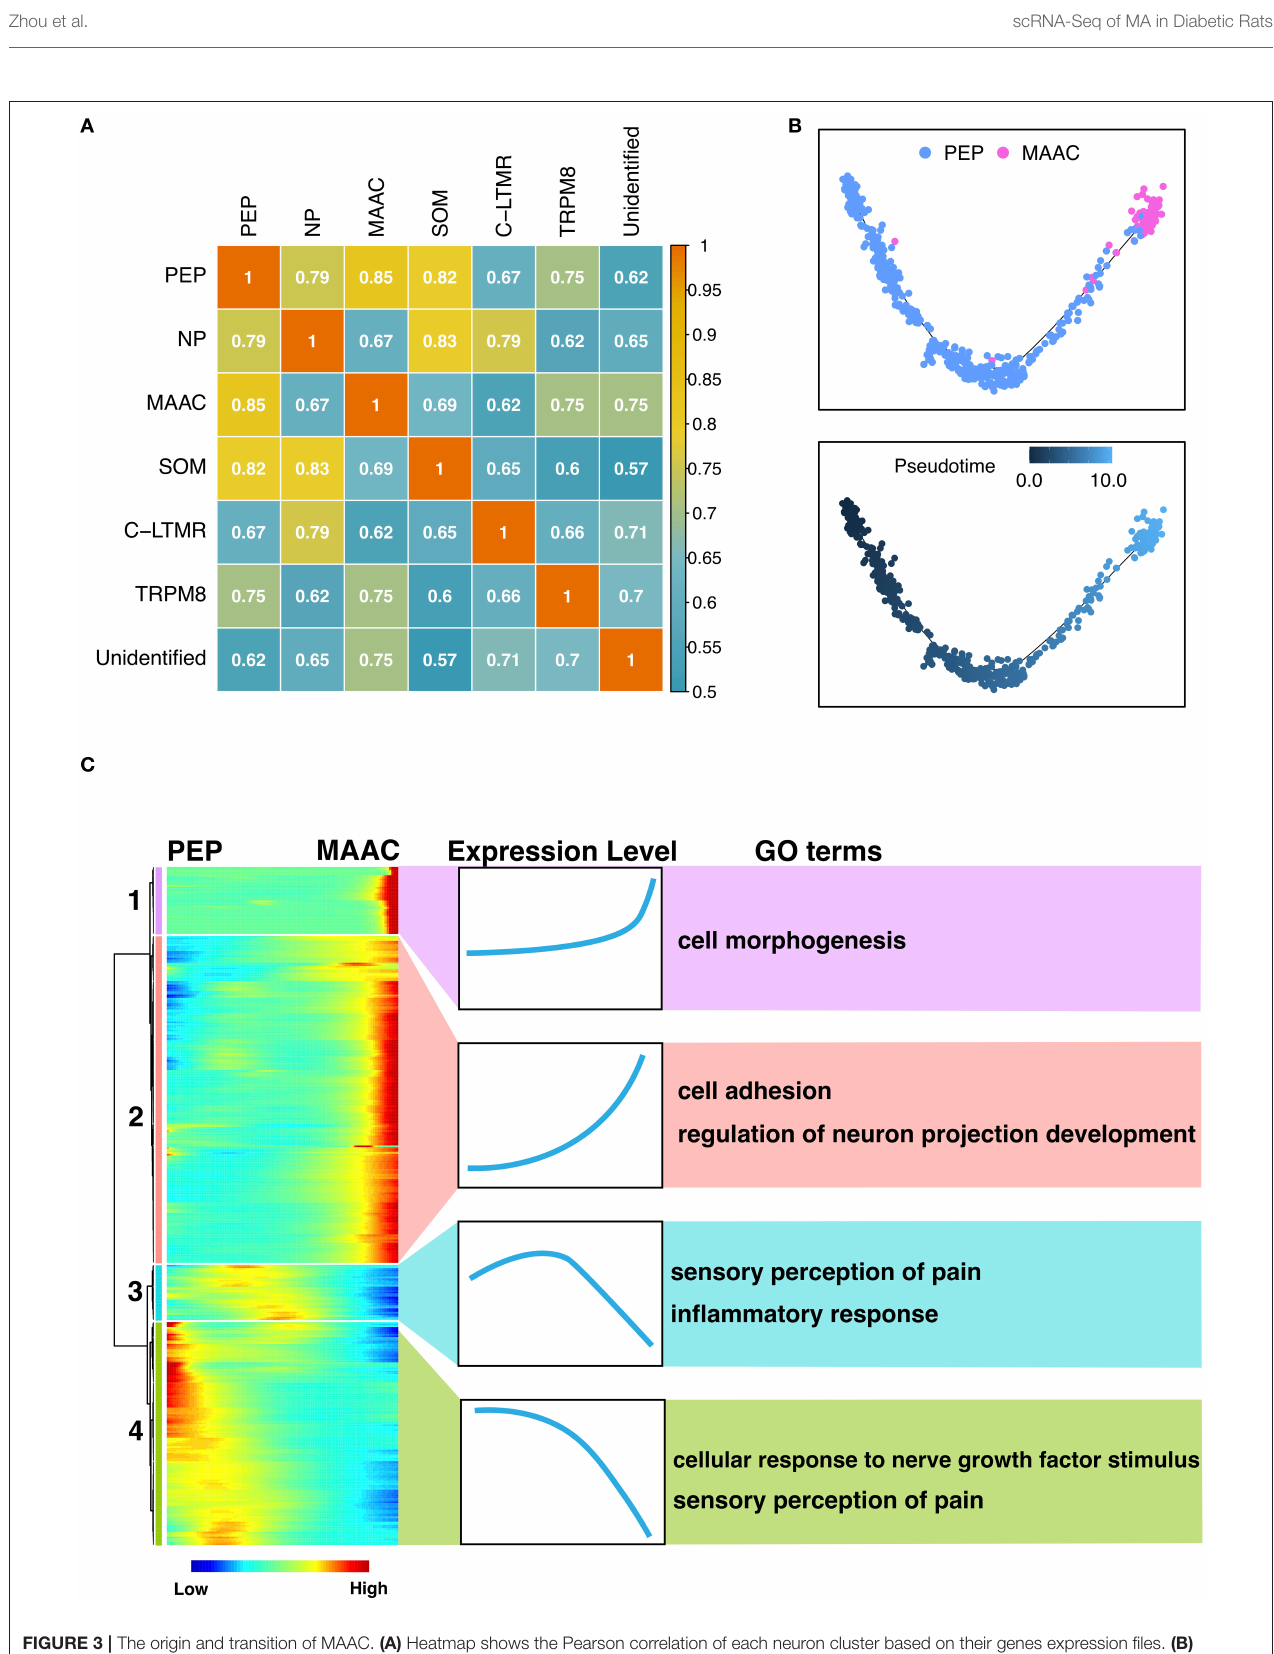
FIGURE 3 | The origin and transition of MAAC. (A) Heatmap shows the Pearson correlation of each neuron cluster based on their genes expression files. (B) Pseudo-time trajectories show the fate of MAAC originated from peptidergic nociceptors (PEP). Dot, cells; colors, neuron clusters or pseudotime. (C) Heatmaps show the DEGs clustered based on their dynamic expression characteristic, which were shown in pseudo-time from PEP to MAAC.